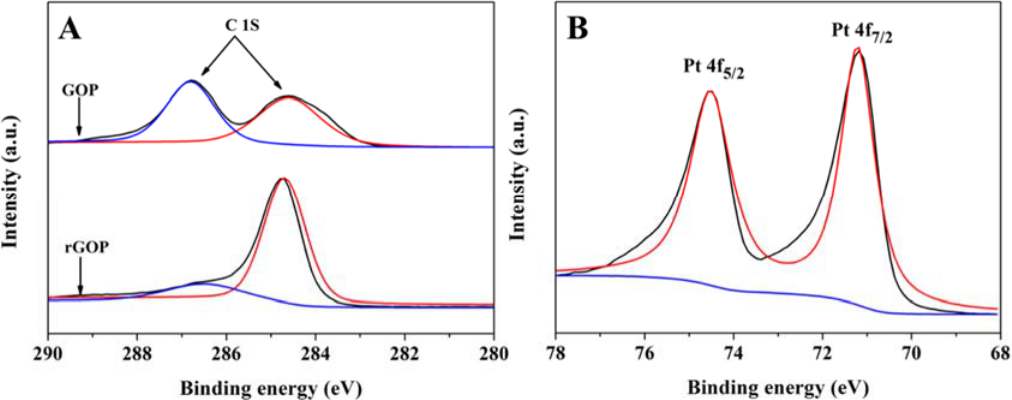
Figure 3. XPS spectra of ( A ) C 1s peak for GOP and rGOP (red line and blue line are the fitting curves). ( B ) Pt 4f peak for rGOP.